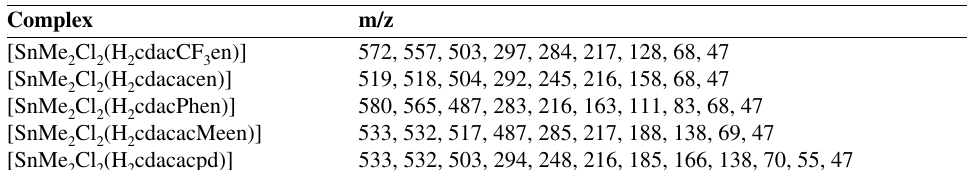
Table 3. Important mass spectral data of the Sn(IV) Schiff base complexes Complex